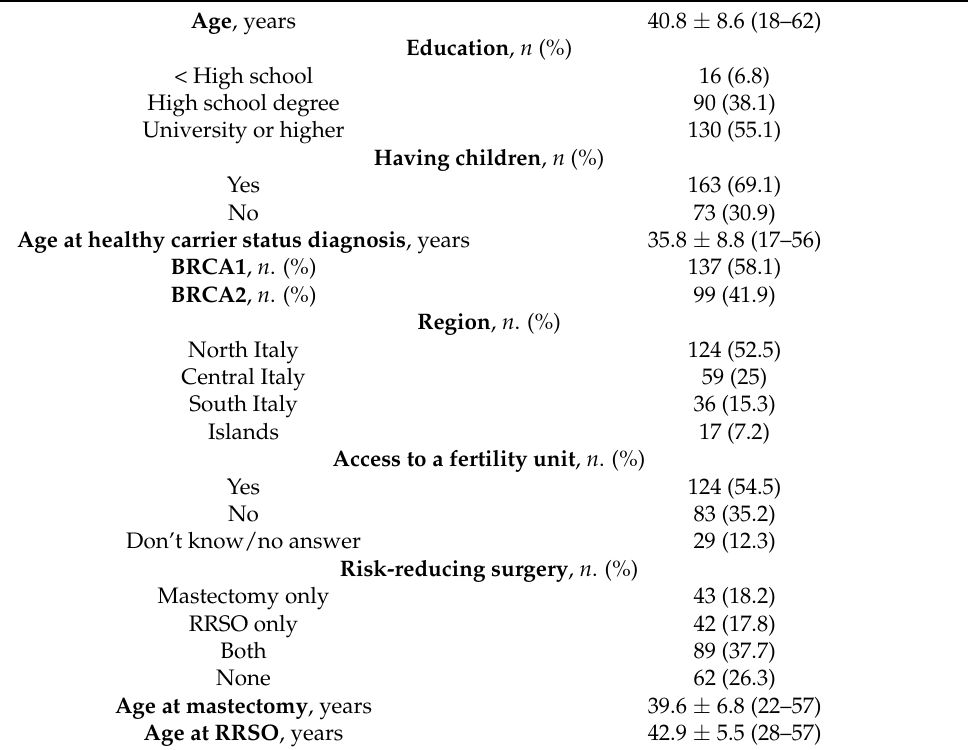
Table 1. Demographic characteristics of study